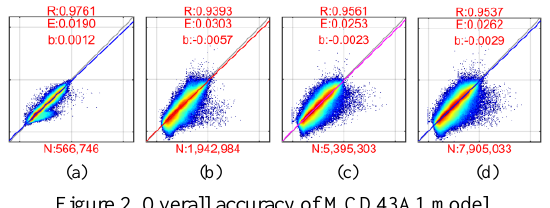
Figure 3. The accuracy of MCD43A1 model on different (a) RAAs and (b) VZAs.